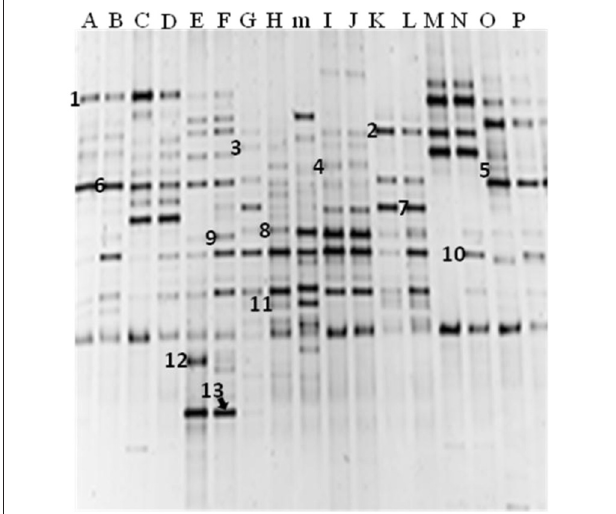
FIGURE 2 | DGGE profiles of PCR-amplified 16S rRNA gene fragments of sixteen (16) fermented iru samples showing major